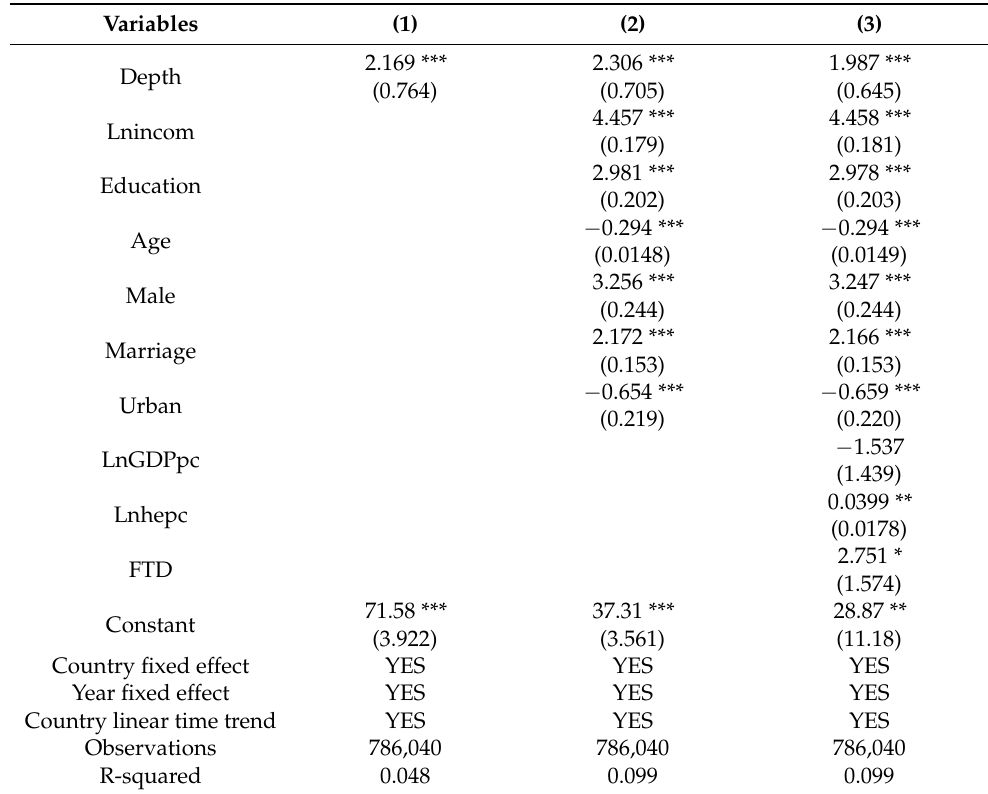
Table 4. Benchmark